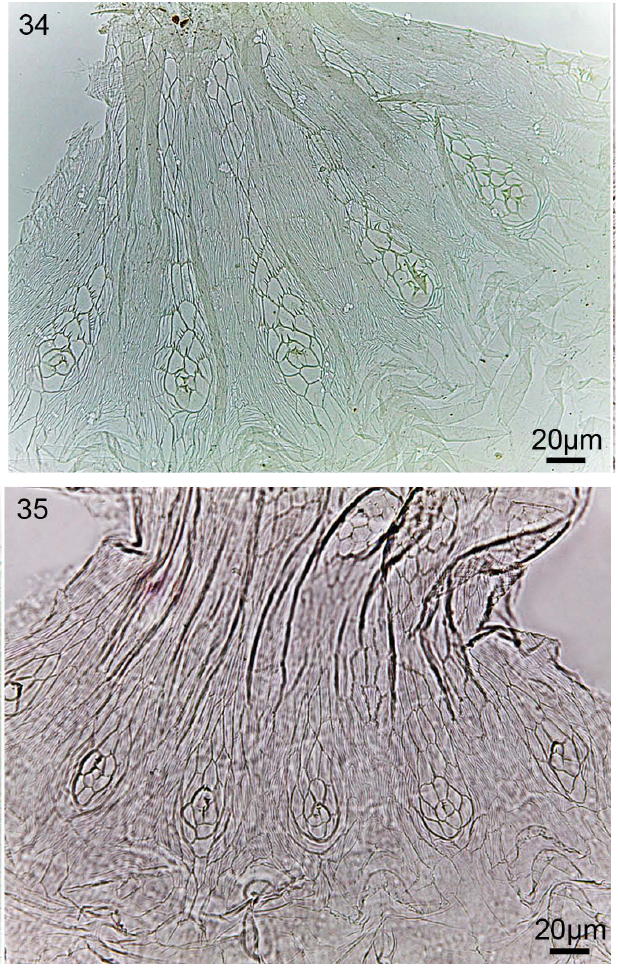
Figs 34–35. Enteric valves of Apicotermitinae: 34- Anoplotermes pacificus, from Ilha do Cardoso, SP; 35- Anoplotermes pacificus , from Santa Teresa, ES. Fig 36 . Tarsi of Agnathotermes sp. (arrows: specialized regions).